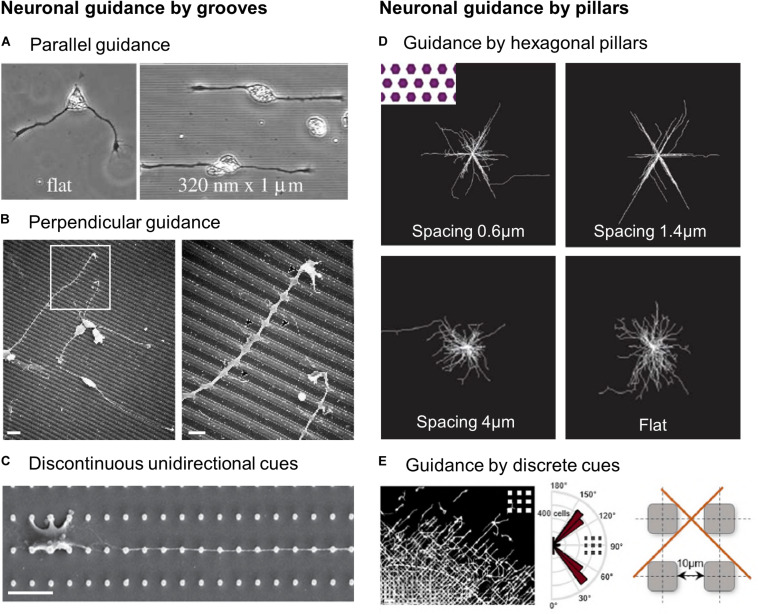
Guidance of neuronal cells by microstructured substrates. (A) Xenopus spinal cord neurons on flat or 1 μm wide, 320 nm deep grooves. Reproduced with permission from Rajnicek et al. (1997). (B) Scanning electron microscopy (SEM) images of cortical neuroblasts on grooves (1 μm width, 0.5 μm depth). Scales 5 μm (left), 2 μm (right). Reproduced with permission from Nagata et al. (1993). (C) SEM image of a primary hippocampal neurons on unidirectional micropillars array. Scale 10 μm. Reproduced with permission from Park M. et al. (2016). (D) Hippocampal neurons alignment on flat or in between hexagonal pillars of various spacing. Reproduced with permission from Kundu et al. (2013). (E) Alignment of migrating cortical interneurons in between square pillars. Scale 50 μm. Reproduced with permission from Leclech et al. (2019).